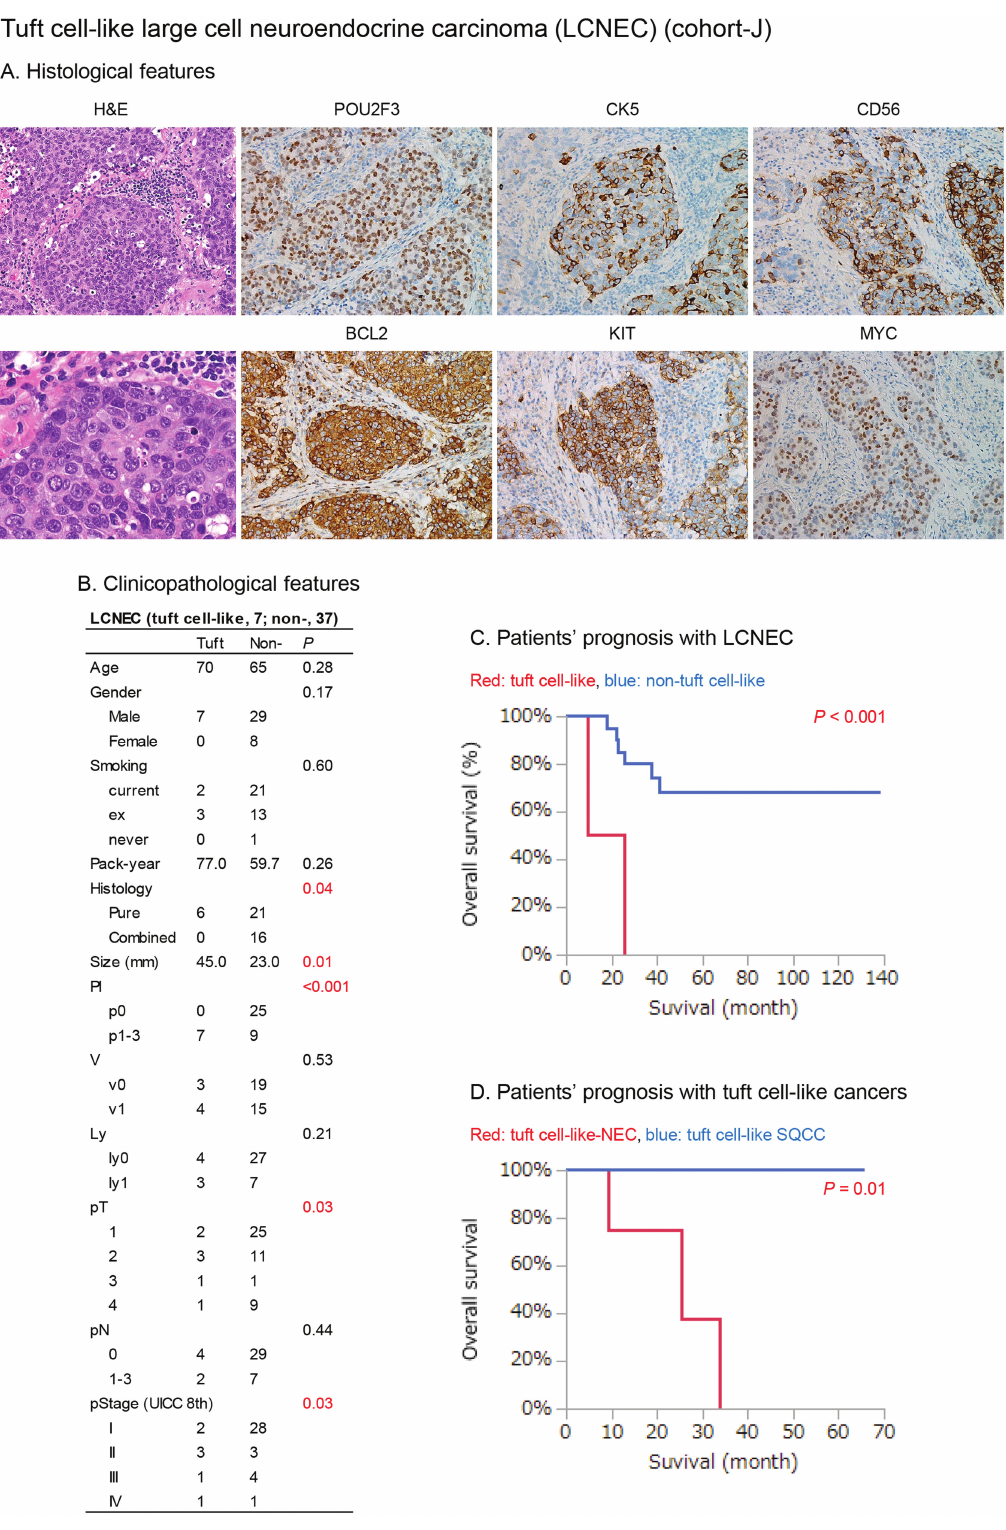
Fig. 1 Clinicopathological fi ndings of tuft cell-like large cell neuroendocrine carcinoma (LCNEC) and patients ’ prognosis with tuft cell-like cancers (cohort-J). A The histology of a tuft cell-like LCNEC (case no.12 in Fig. S2). The tumor shows a nested growth pattern and vague rosetting. The tumor cells show non-small cell lung cancer cytology (conspicuous nucleoli, moderate amount of cytoplasm) and are diffusely positive for POU2F3, and focally positive for CK5 and CD56. The tumor cells are also positive for BCL2, KIT, and MYC. B Clinicopathological features. Pl, pleural invasion; V, vascular invasion (v0: − , v1: + ); Ly, lymphatic invasion (ly0: − , ly1: + ) C , D Patients ’ prognosis. Tuft cell-like LCNECs exhibit a signi fi cantly poorer prognosis than non-tuft cell-like LCNECs (C). Tuft cell-like NECs (i.e., the joint tuft cell-like SCLCs and LCNECs, N = 12) exhibit a signi fi cantly worse prognosis than tuft cell-like SQCCs ( N = 5) (D).